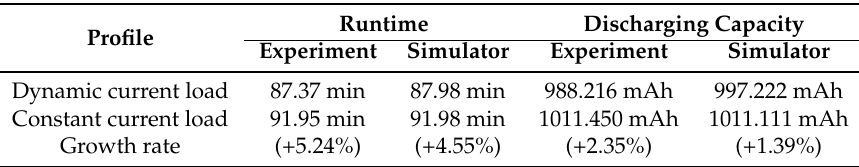
Figure 17. Experimental data and simulation results of the proposed battery simulator: ( a ) load current; ( b ) battery voltage; and ( c ) discharging capacity. Table 6. Experimental data and simulation results of the proposed battery